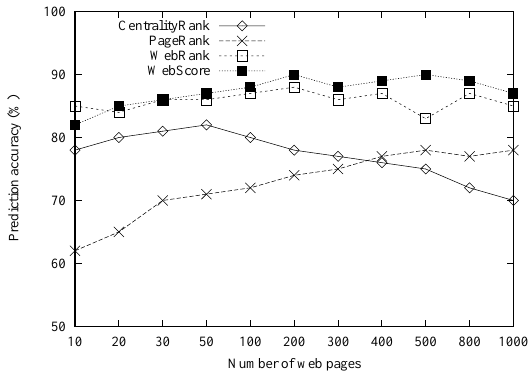
Fig. 4. Scoring accuracy comparison among algorithms un- der five WSNs with 500